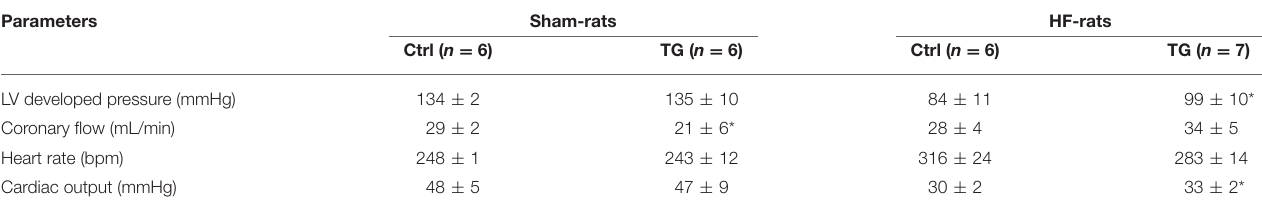
TABLE 1 | Modulation of OGA inhibition by thiamet G in isolated perfused heart.